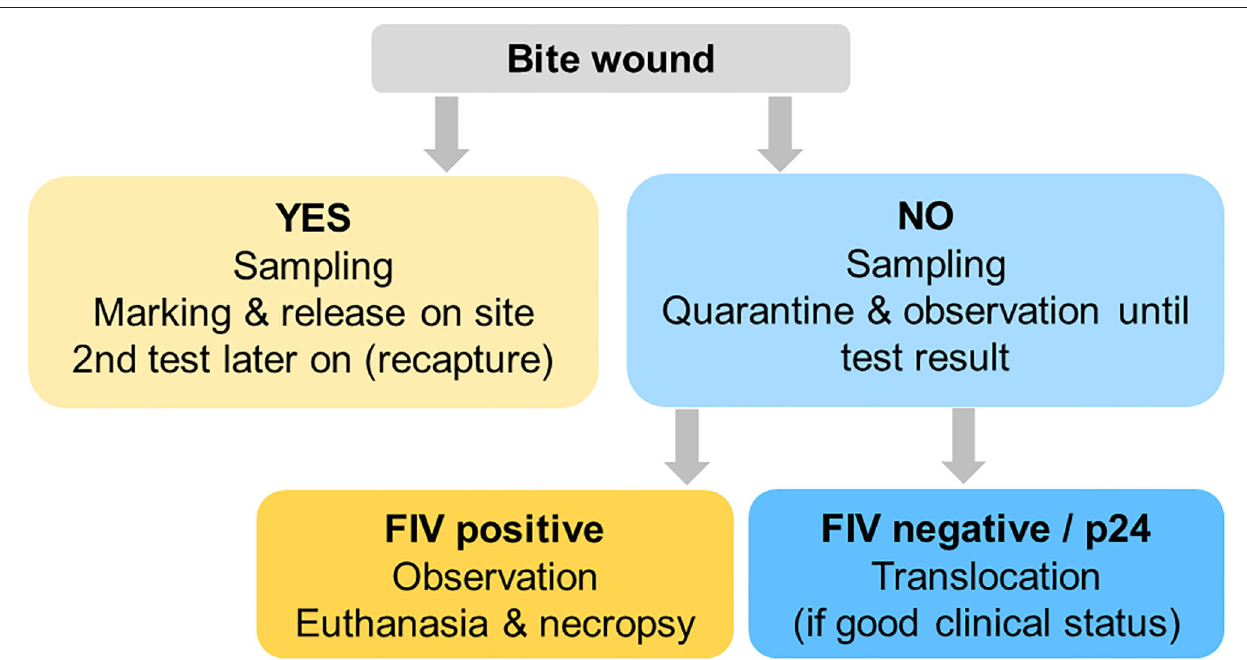
FIGURE 11 | Decision scheme 2017–2020 for lynx captured for translocation purposes, aiming at minimizing the disease risk potentially associated with a feline immunodeficiency virus infection without jeopardizing conservation